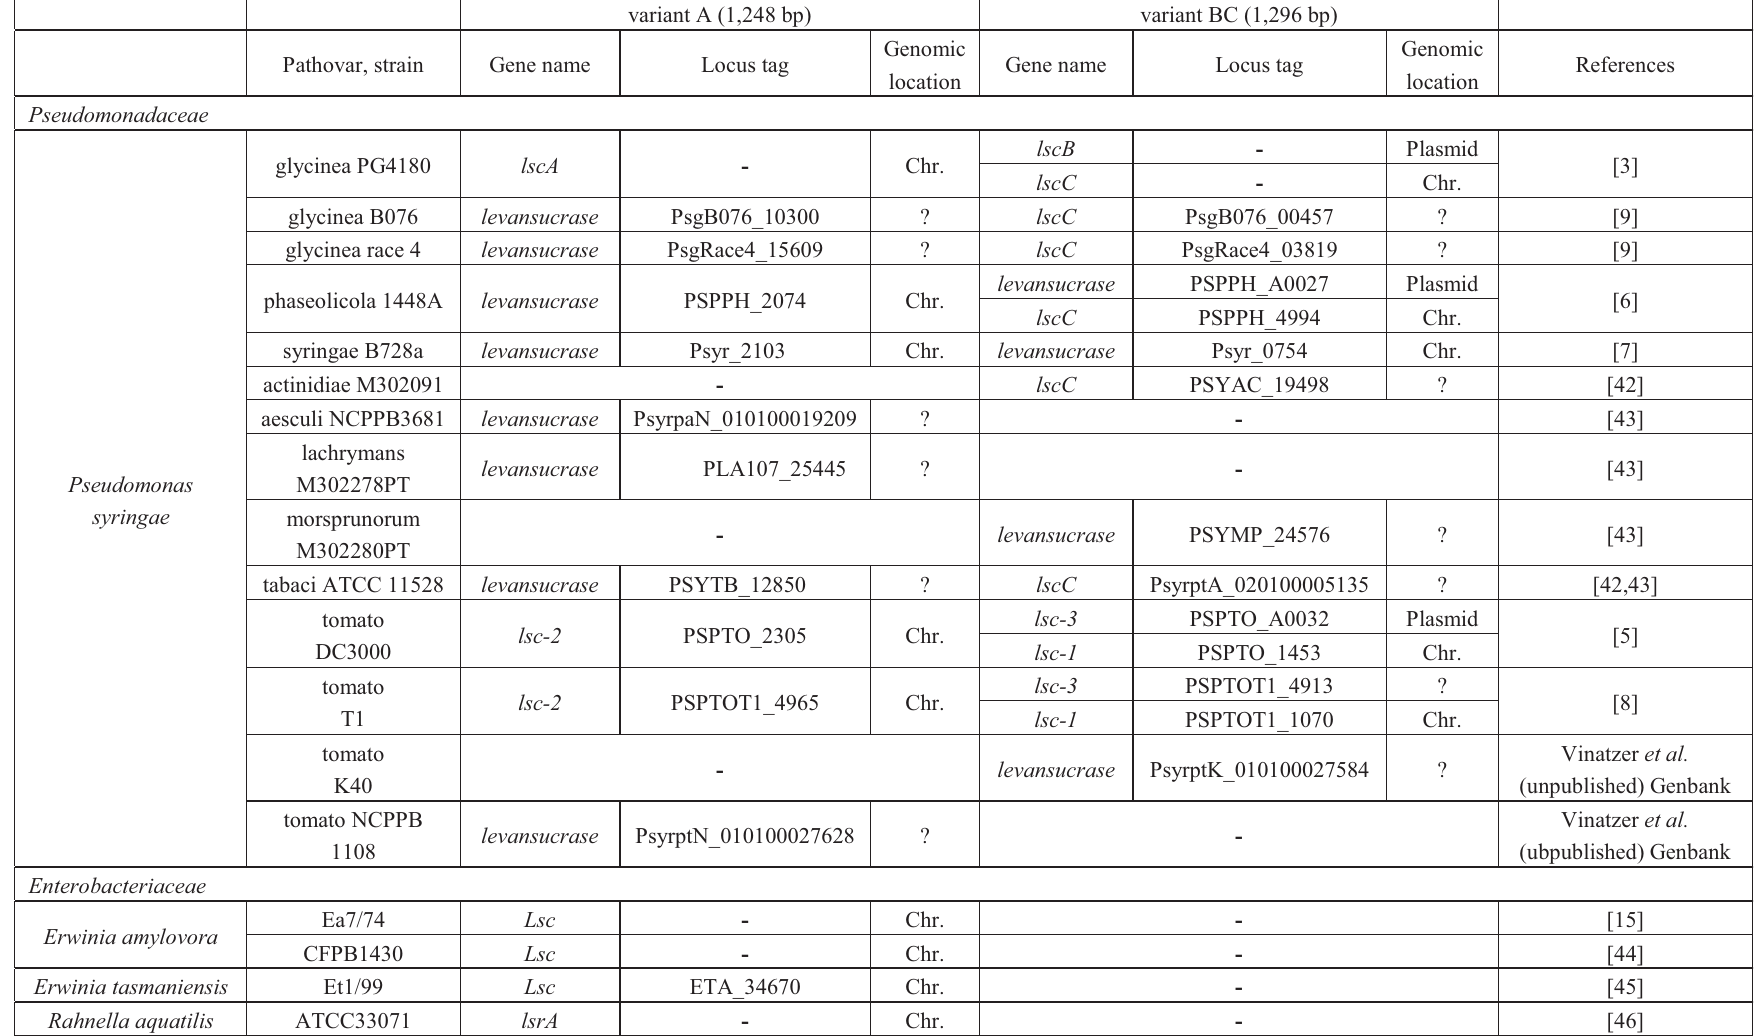
Table 1. Distribution of variant A and variant BC alleles in Pseudomonadaceae and Enterobacteriaceae